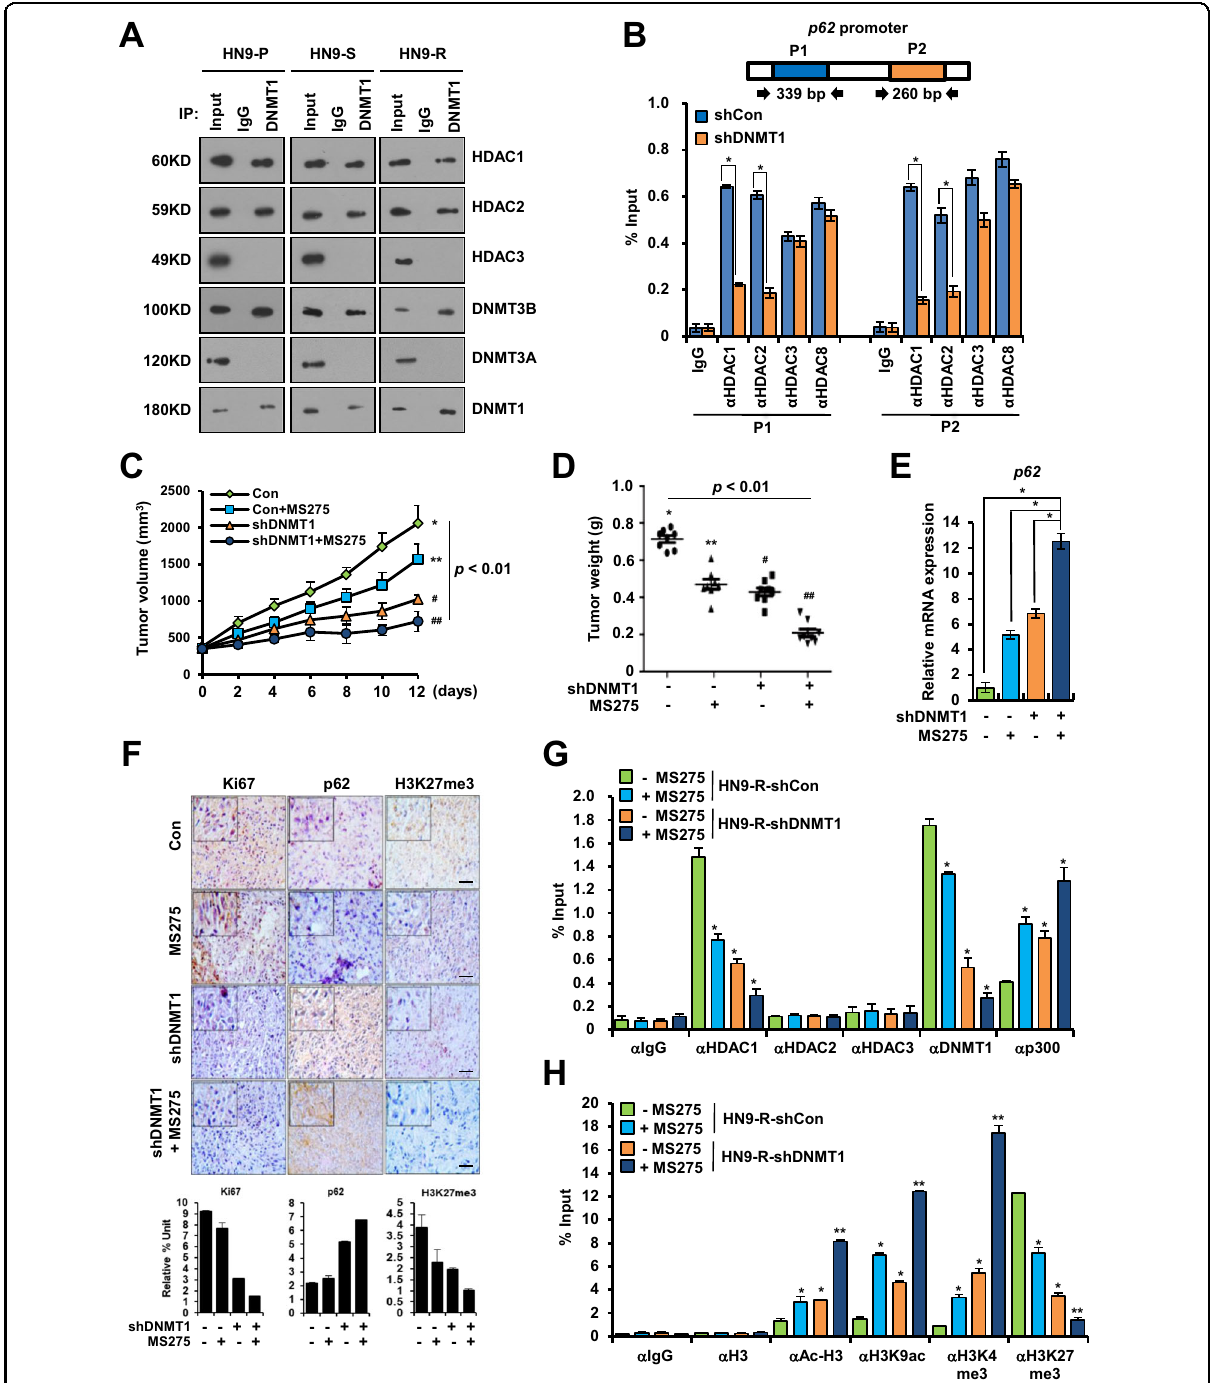
Fig. 4 Recovery of p62 expression via the inhibition of DNMT1 and HDAC1 decreases the tumorigenicity of HN9-R clones. A Immunoprecipitation analysis of interactions between DNMT1 and HDACs in HN9-P, HN9-S and HN9-R cells. B Analysis of the ChIP assay of the p62 promoter regions (P1 and P2) with antibodies against HDACs in HN9-R clones. The results obtained from three independent biological replicates were represented as percentage of input (% input). C , D In vivo tumorigenesis ( C ) and tumor weight ( D ) of DNMT1-depleted HN9-R clones with HDAC inhibitor (MS275) treatment. Statistical analyses were determined by ANOVA with Bonferroni correction. Means with different superscript letters are signi fi cantly different ( p <0.01). E p62 mRNA expression in DNMT1-depleted HN9-R in response to treatment with MS275. F Immunohistochemistry and the quantitative analysis of Ki67, p62, and H3K27me3 expression in DNMT1-depleted HN9-R in response to treatment with or without MS275. Scale bars, 50 μ m. G , H ChIP analysis of the p62 promoter performed with antibodies against HDACs, DNMT1, p300, and H3 histone modi fi cation in DNMT1-depleted HN9-R xenograft tumor tissues treated with MS275. Values are means ± standard deviation (SD) for eight mice ( C – H ). * p <0.05; ** p